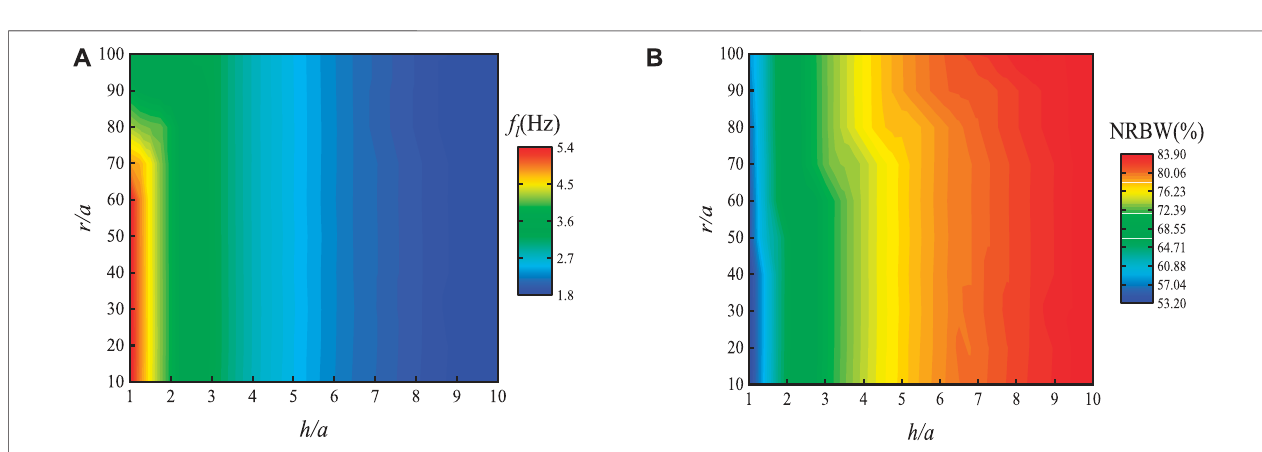
Frontiers in Materials |